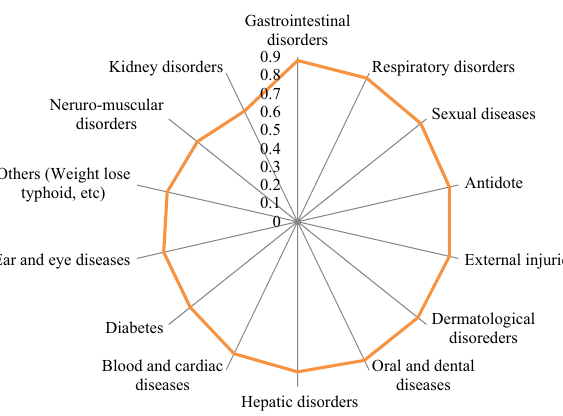
Figure 6: ICF of disease